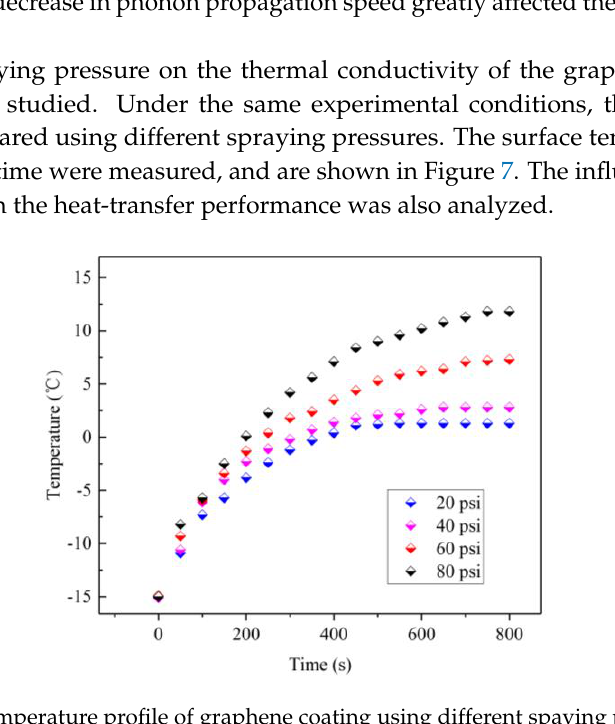
Figure 7. Temperature profile of graphene coating using different spaying pressures.